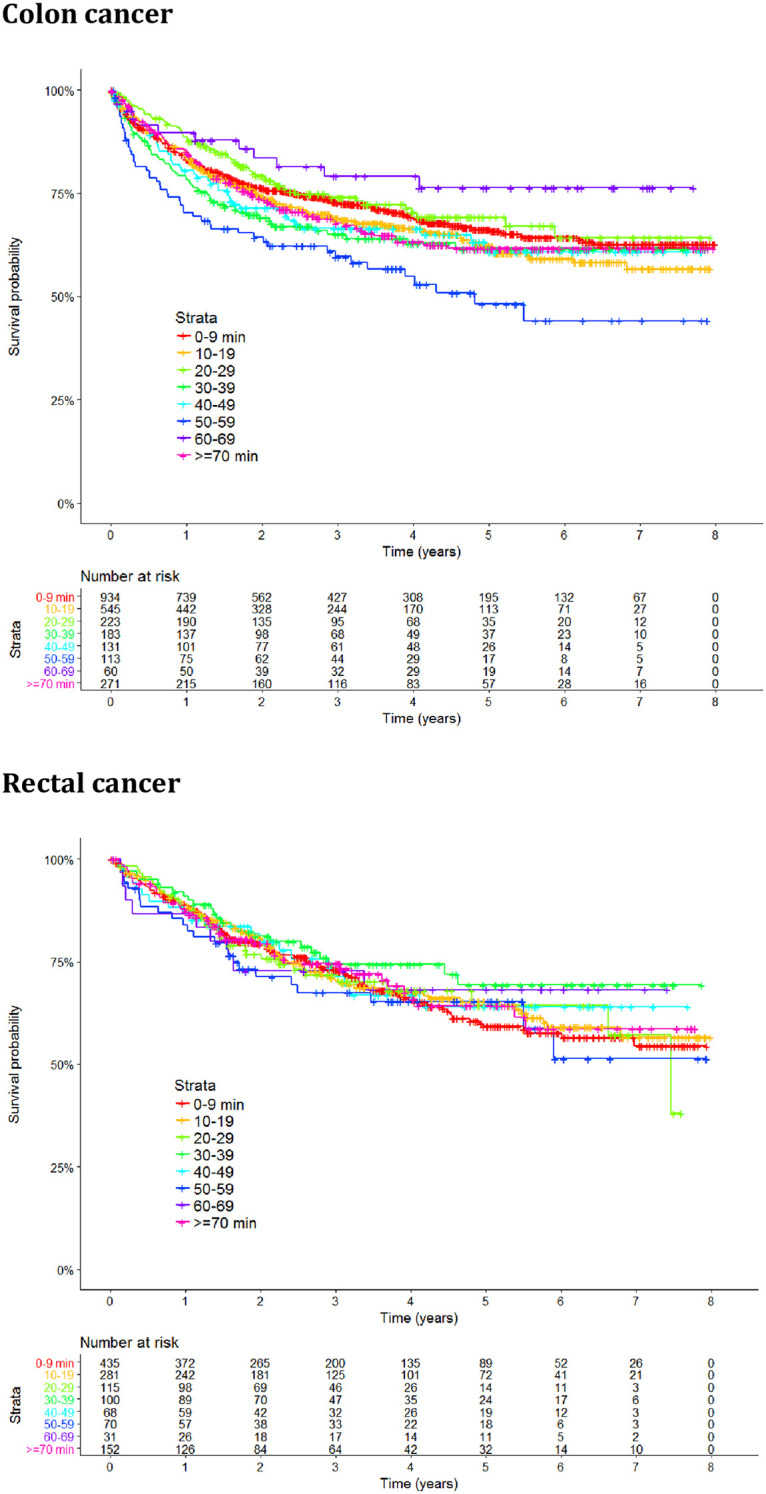
Kaplan-Meier plots for cause-specific survival for patients with colon and rectal cancer respectively by travel time to the nearest hospital.